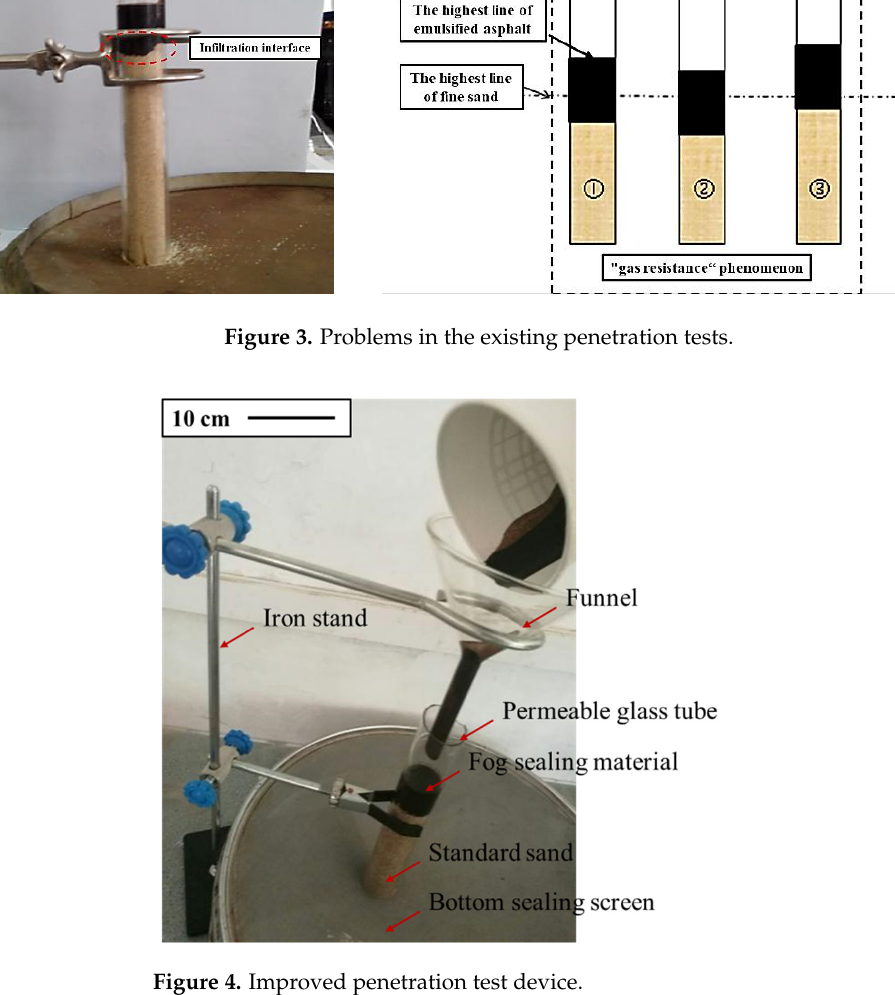
Figure 4. Improved penetration test device.